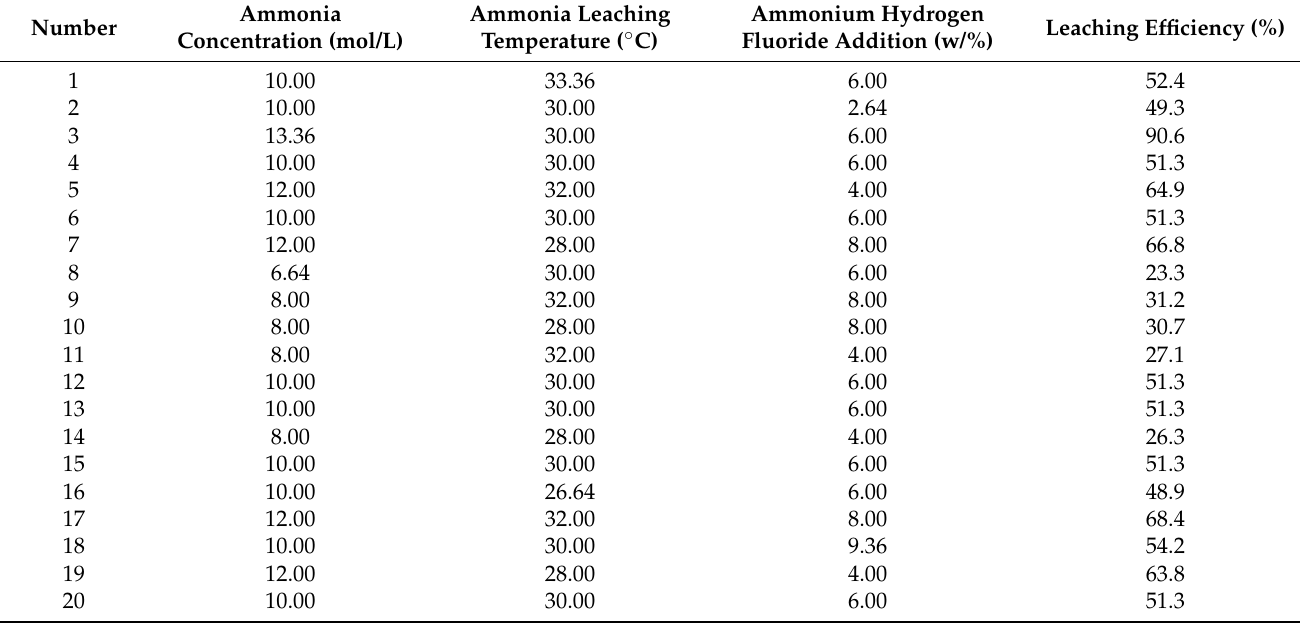
Table 3. The experimental scheme and results of CCD variables in ammoniacal leaching of the roasted manganese ore by ammonium